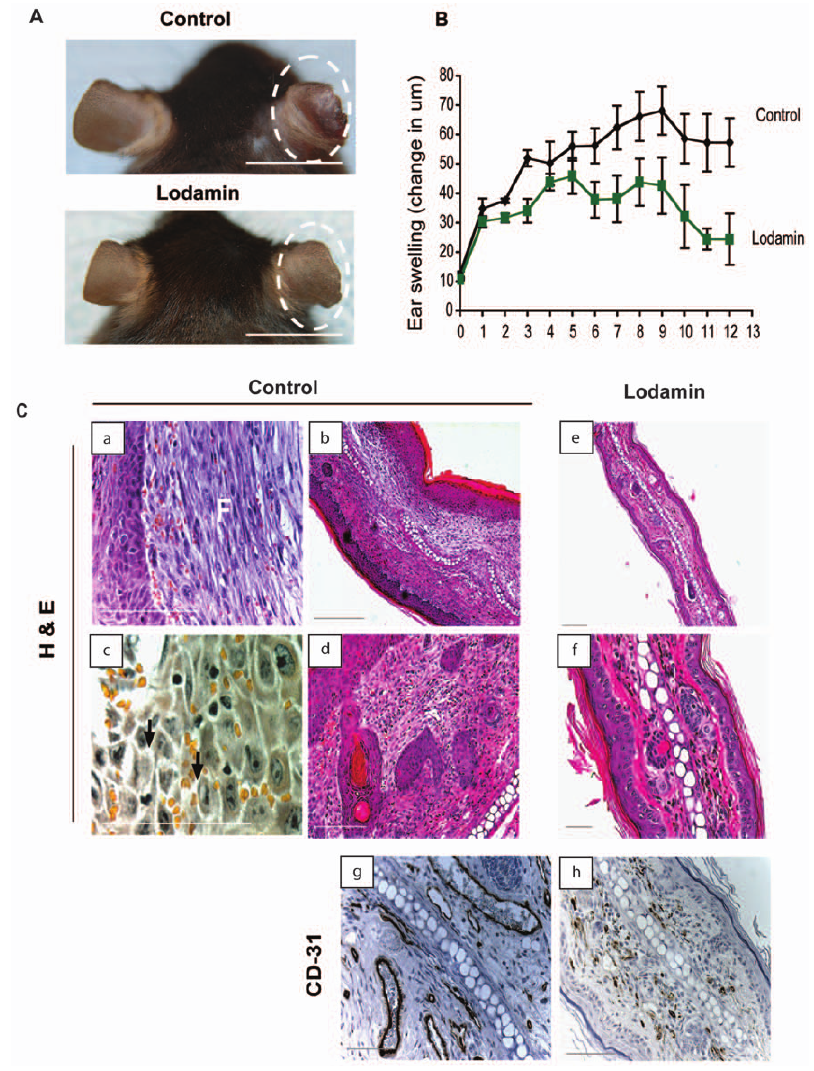
Figure 2. Lodamin inhibits angiogenesis, inflammation and edema in the DTH reaction. ( A ) Lodamin suppressed ear swelling in DTH reactions elicited by oxazolone, photos of representative ears of Lodamin treated or untreated mice are circled. Bar=1 cm ( B ) Ear swelling is represented as change in thickness (in m m) compared to original ear thickness. Mice treated with Lodamin (white squares) showed a significant reduction in ear thickness compared to control mice (black squares). The differences were statistically significant from day 2 to day 12 post challenge, excluding day 5 ( P , 0.05). Data are presented as an average 6 SEM, n=5. ( C ) Immunohistological analysis of mouse ears post DTH reaction: H&E staining (a–f) and specific staining of endothelial cell marker CD-31 (g–h). In H&H staining, control ears exhibited an excessive inflammation and edema (a–d), including fibroblast proliferation (marked as F) and spongiosis pointed by arrows compared with Lodamin treated mice (e–f). Bar=50 m